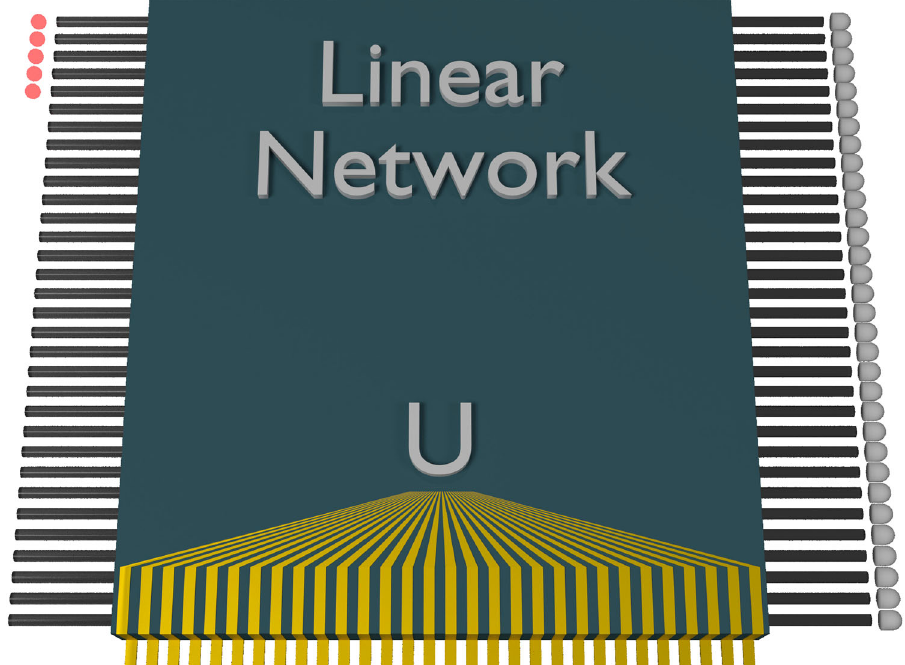
Fig. 2 Schematic representation of a 5 photon, 32 mode instance of the BosonSampling problem. The photons are injected individually into the input modes ( left ), interacted linearly through a linear network that has scattering matrix u which is classically controlled ( bottom ) and all outputs are detected in the Fock basis ( right